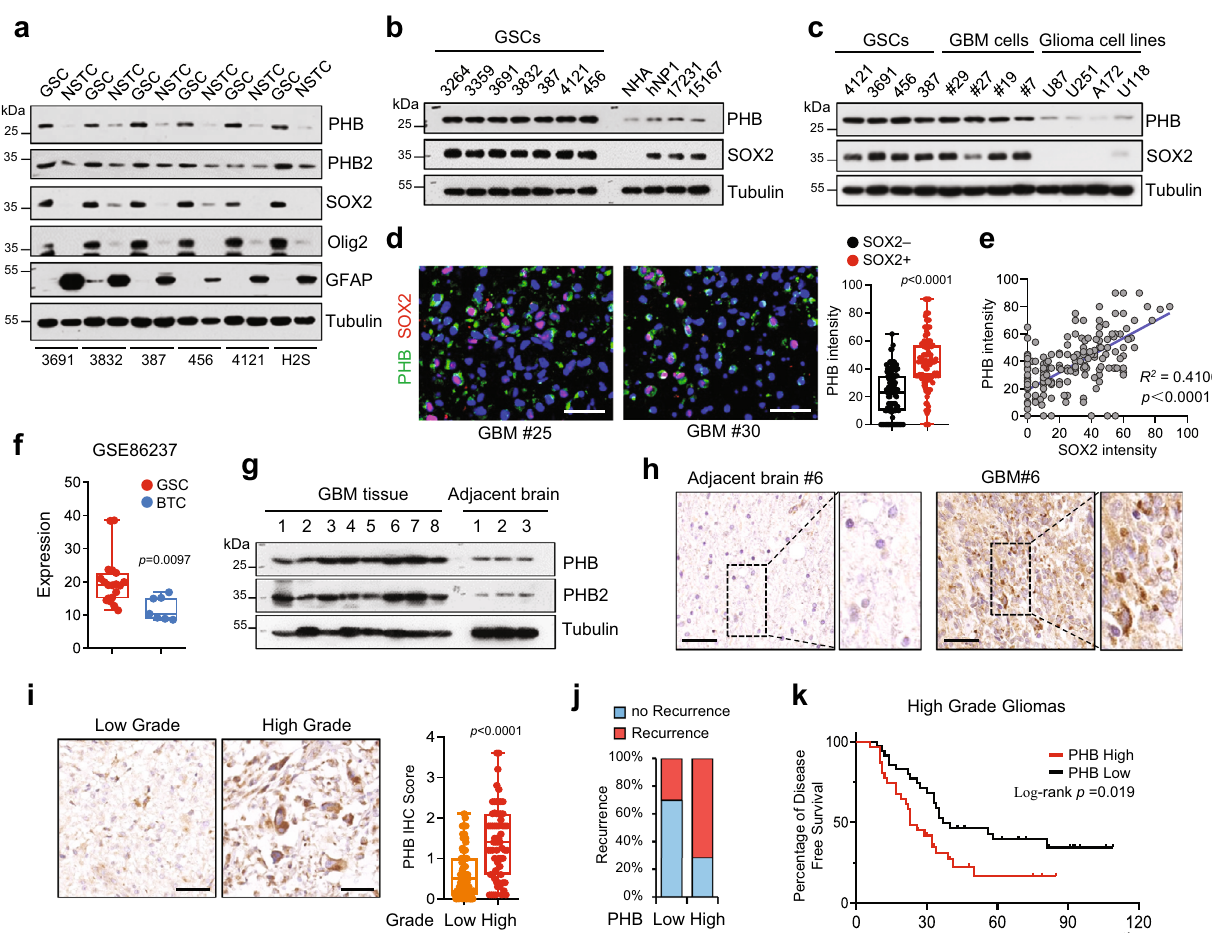
Fig. 1 PHB is highly expressed in GSCs. a – c Immunoblot (IB) showing the expression of indicated proteins in glioma stem-like cells (GSCs) and matched non-stem tumor cells (NSTCs) ( a ), in GSCs, normal human astrocyte (NHA), and human neural progenitor cells (hNP1, 17231, and 15167) ( b ), or in GSCs, primary GBM cells and established glioma cell lines ( c ). d and e Representative immuno fl uorescent (IF) images of human primary glioblastoma (GBM) specimens stained with anti-PHB (green) and anti-SOX2 (red). Nuclei were counterstained with Hoechst (blue) ( d , left). Scale bars, 40 μ m. Quanti fi cations of PHB staining intensity in SOX2 + ( n = 110) and SOX2 − ( n = 100) cells ( fi ve random microscope fi elds from three tumors) are shown ( d , right). Pearson ’ s correlation coef fi cient between PHB and SOX2 staining intensity in GBM cells is shown ( e ). f mRNA expression of PHB in GSCs ( n = 19) relative to bulk tumor cells (BTCs, n = 7) from GEO pro fi le (GSE86237) are shown. g IB showing the levels of PHB and PHB2 in human primary GBM tissues and adjacent normal brain tissues. h Immunohistochemical (IHC) staining of PHB in primary GBM and matched adjacent brain tissue. Scale bars, 100 μ m. i – k IHC analysis of PHB in a glioma tissue microarray. Representative images and boxplots of histoscore of PHB in low grade and high grade gliomas are shown ( i ). Scale bars, 50 μ m. (low grade, n = 94; high grade, n = 66). The percentages of recurrence of gliomas in tumors with low ( n = 79) or high ( n = 81) expression of PHB are shown ( j ). Kaplan – Meier survival analysis of patients with PHB low ( n = 35) and PHB high ( n = 31) expression in high-grade gliomas are shown ( k ). (Log-rank Mantel – Cox test). See Supplementary Table 1. Boxplots represent the median, 25th, and 75th percentiles. The maximum and minimum are connected to the center box through the vertical lines (whiskers). d , f , i Unpaired two-sided Student ’ s t -test ( d , f ), Welch ’ s two-sided t- test ( i ). Source data are provided as Source Data fi examined the levels of miR-27a in GSCs, matched NSTCs and normal brain cells. In contrast to the high expression of PHB in GSCs, miR-27a was highly expressed in NSTCs, NHA, and hNP1 (Supplementary Fig. 2b, c). Transduction of GSCs with miR-27a mimics signi fi cantly decreased the expression of PHB (Supple- mentary Fig. 2d, left). However, transduction of the miR-27a inhibitor upregulated the mRNA levels of PHB in GSCs (Supplementary Fig. 2d, right). To further explore whether miR-27a suppresses PHB expression directly through the putative binding site in the 3 ′ UTR of PHB , we generated luciferase reporter constructs containing the wild-type or mutated miR-27a- binding site (Supplementary Fig. 2e). Co-transfection of the wild- type binding site reporter with miR-27a mimic or with miR-27a inhibitor, respectively, decreased or increased luciferase reporter